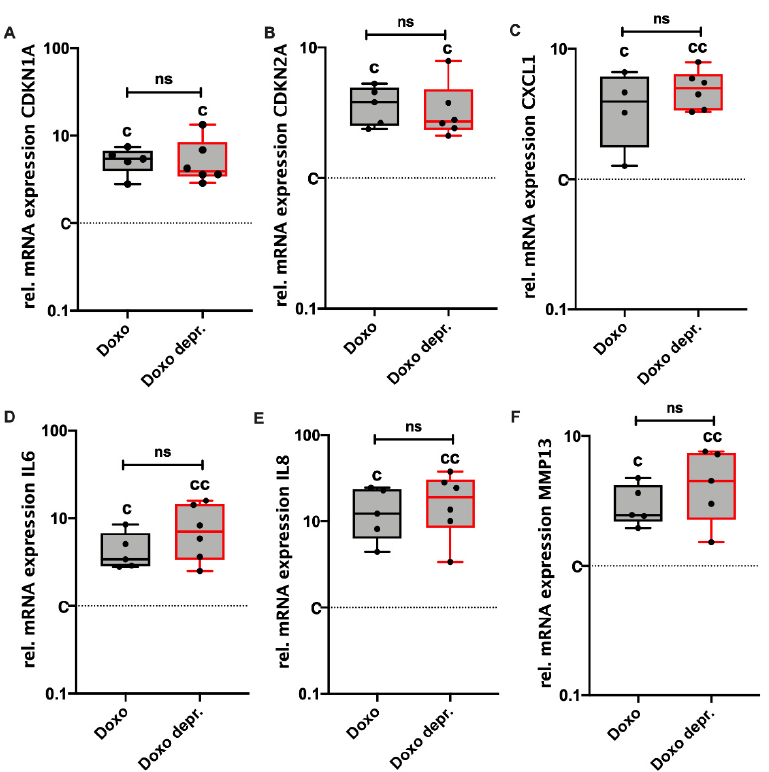
Figure 6. Continuing effect of Doxo stimulation on the gene expression of SA markers. Gene expression levels of ( A ) CDKN1A, ( B ) CDKN2A, ( C ) CXCL1, ( D ) IL6, ( E ) IL8, and ( F ) MMP13 were analyzed in hAC stimulated with 0.1 µ M Doxo for 7 d. Doxo = analysis directly after 7 d of Doxo stimulation; Doxo depr. = analysis 7 d after deprivation of Doxo. Data are presented as box plots with median, whiskers min to max. Significant differences relative to unstimulated hAC are depicted as: cc = p ≤ 0.01; c = p ≤ 0.05. Statistical analysis: ( A – F ) one-way ANOVA, Sidak’s multiple comparisons test. Ctrl = control (unstimulated cells), rel. = relative, ns = not significant.